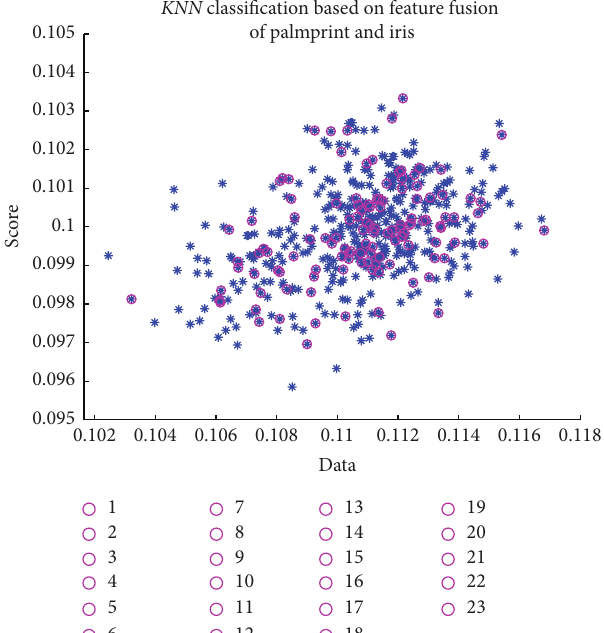
Figure 9: 𝐾 NN classification for the proposed multifeature fusion multimodal biometric. Table 2: Matching scores using 𝐾 -means algorithm.